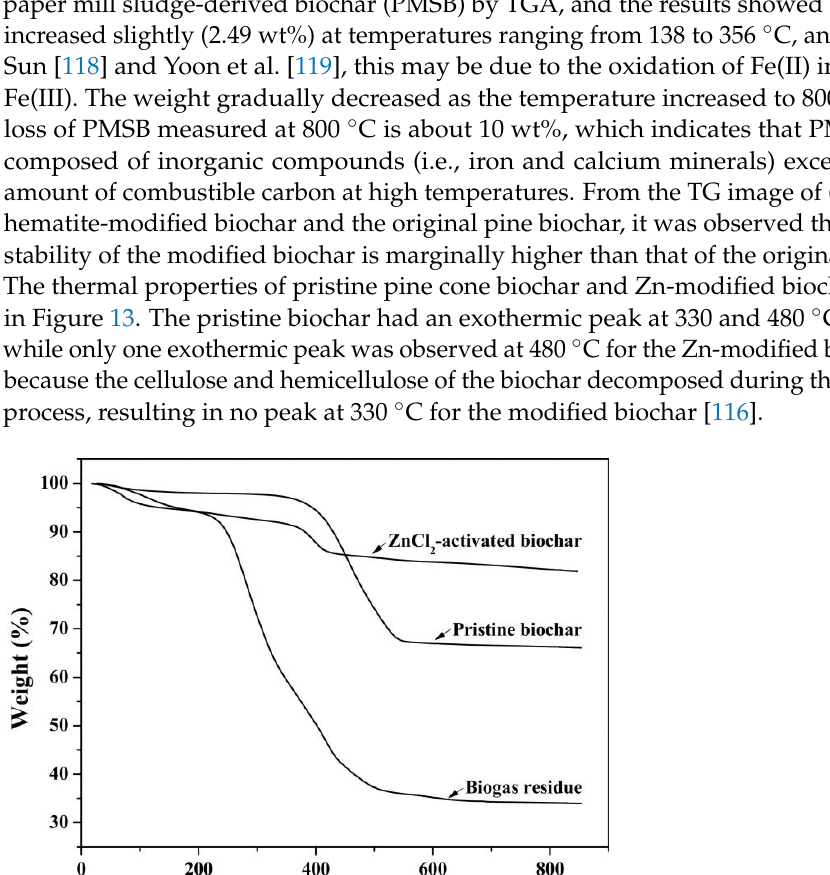
Figure 12. Thermogravimetric Analysis (TGA) of Pine Biochar (PB) and Hematite-Modified Biochar (HPB) [51]. Reprinted with permission from Shengsen Wang et al. (2014). Copyright 2014, Elsevier.